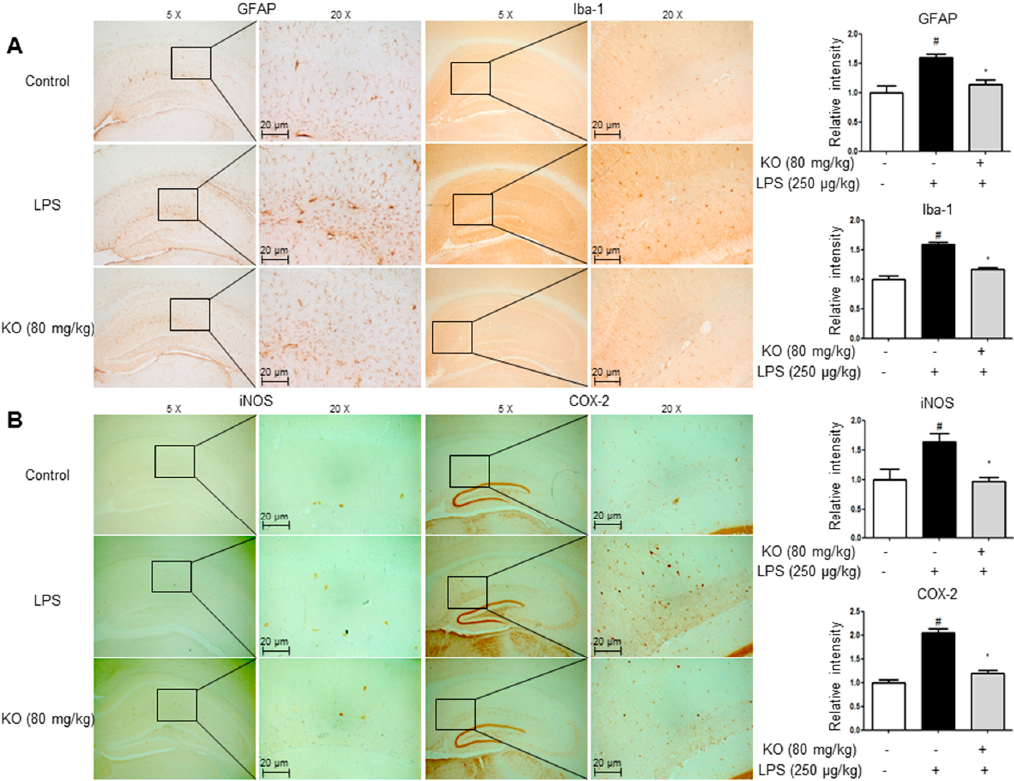
Figure 3. Effect of Krill oil on LPS-induced neuroinflammation in the mouse brain. Immunostaining of GFAP, Iba-1, iNOS, and COX-2 proteins in the hippocampus were performed in 20 µm-thick sections of mice brain with specific primary antibodies and the biotinylated secondary antibodies ( A , B ). Similar patterns were observed in five mice brain. Group differences were analyzed by one-way ANOVA followed by Bonferroni’s post-hoc analysis. # Significantly different from control group ( p < 0.05). * Significantly different from LPS-treated group ( p <